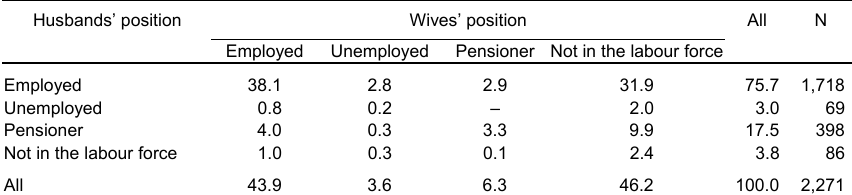
Tab. 1 Labour market positions of husbands and wives aged 18-65. Italy 2001. Cell percentages